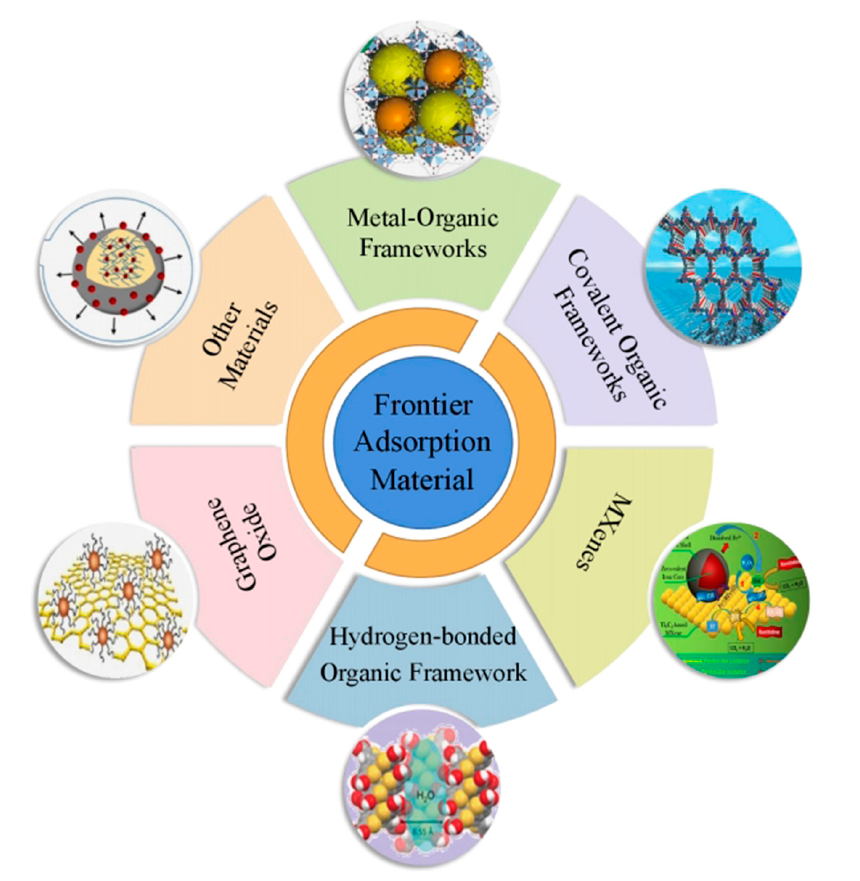
Figure 3. Frontier material classification map.